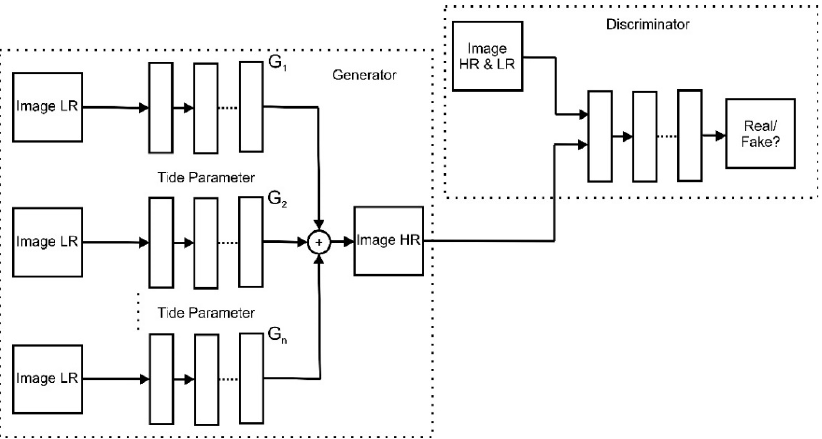
Figure 3. Example of splitting an array image into a four-piece image, then inputting it into Generator EnsGAN.